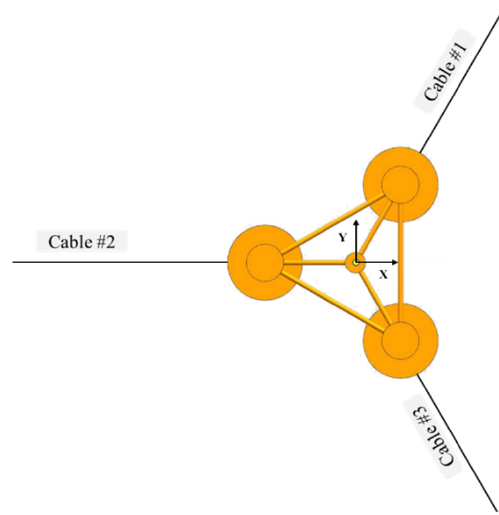
Figure 3. Sketch of the mooring system. Table 2. Mooring system properties.